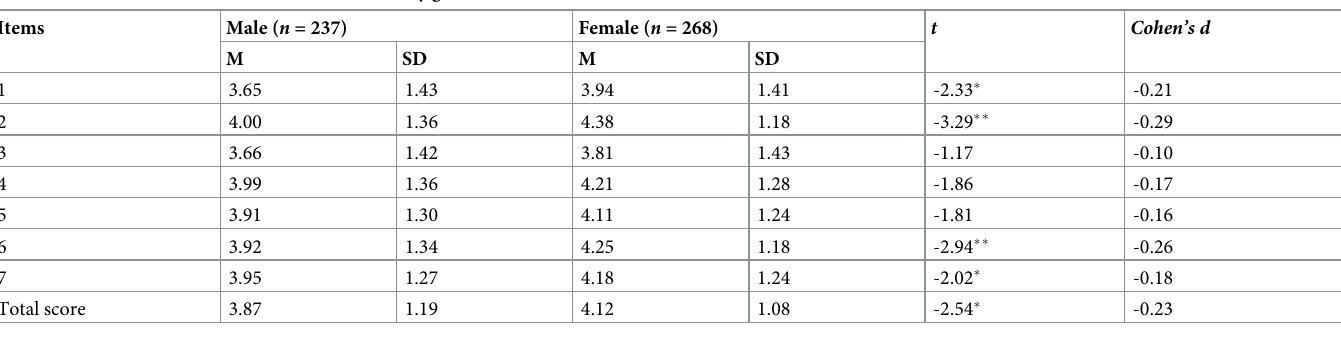
Table 3. Mean and deviation of the ABSDS items by gender.